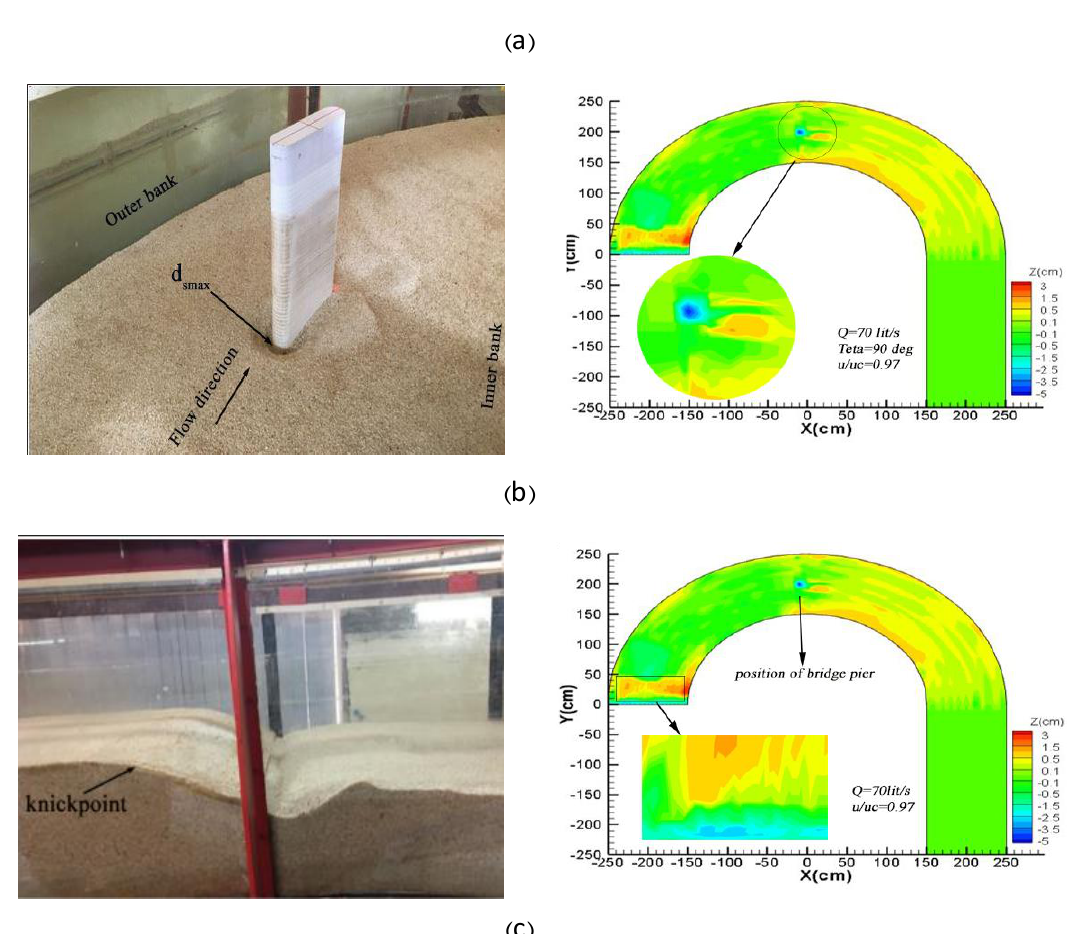
Figure 7. bed topography variations of the experiment on the oblong-nosed rectangular pier in the 90 degree position of the bend a) without base-level drop, b) with base-level drop, and c) for the hole created at